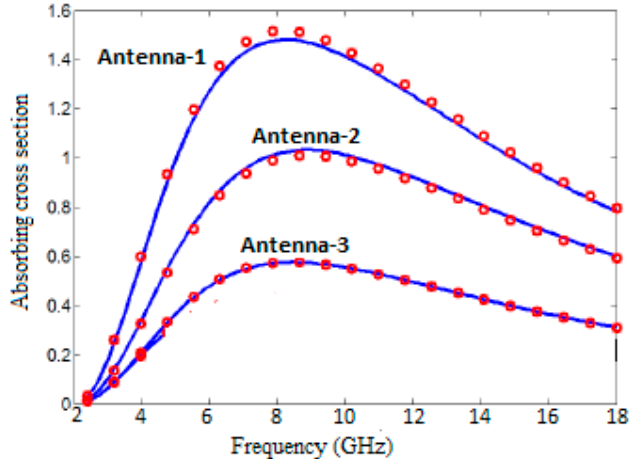
Figure 6. Absorbing cross-section in ( µ m) 2 of Antenna-1, Antenna-2, and Antenna-3 with T = 300 K, µ e = 0 eV in CST Microwave Studio.